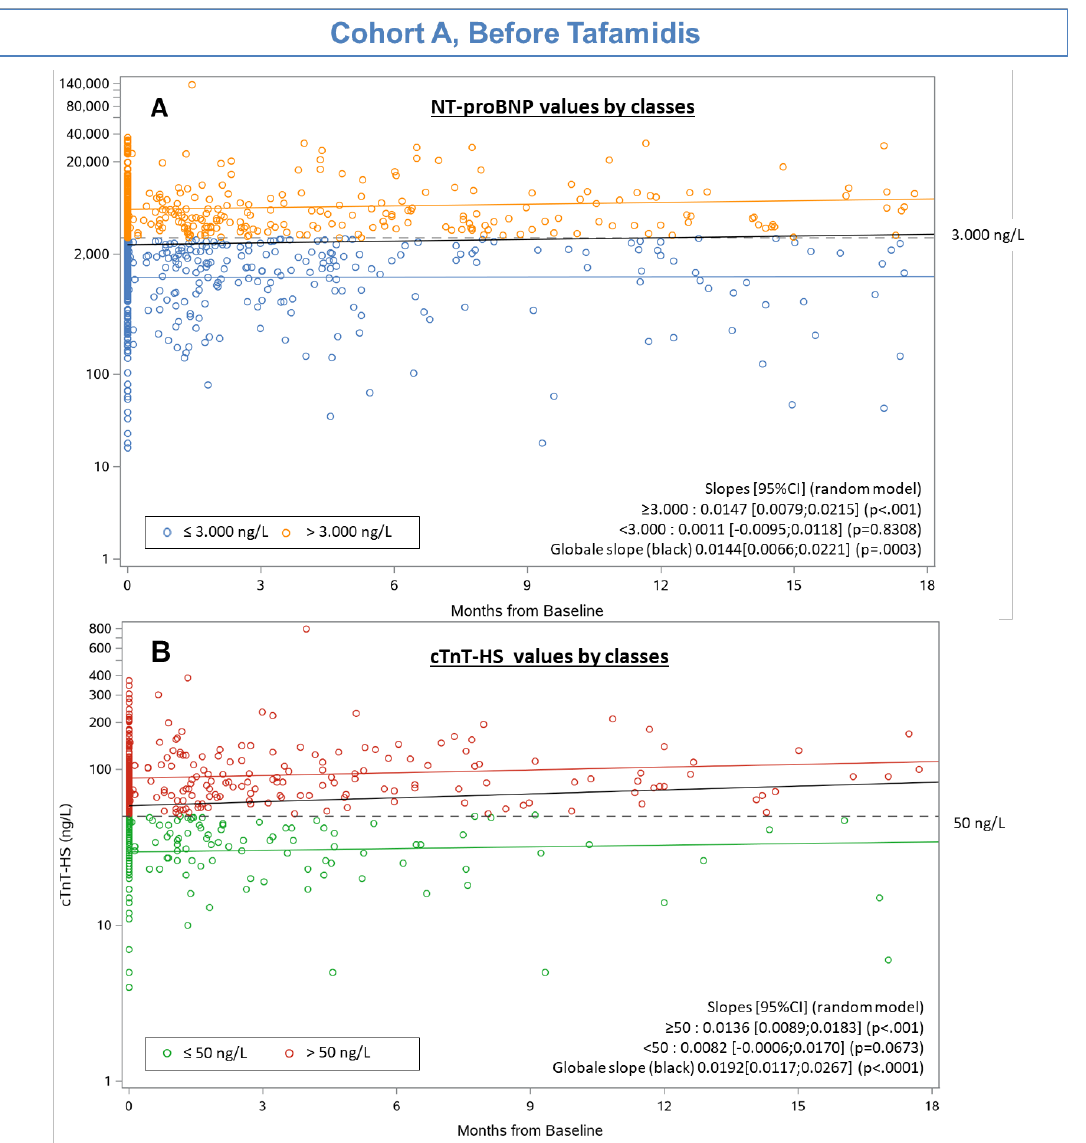
Figure 2. Evolution of biomarkers in Cohort A: Scatter plots of the evolution of log (NT-proBNP) ( A ) and log (cTnT-HS) ( B ) levels with time, for patients in Cohort A ( n = 454).